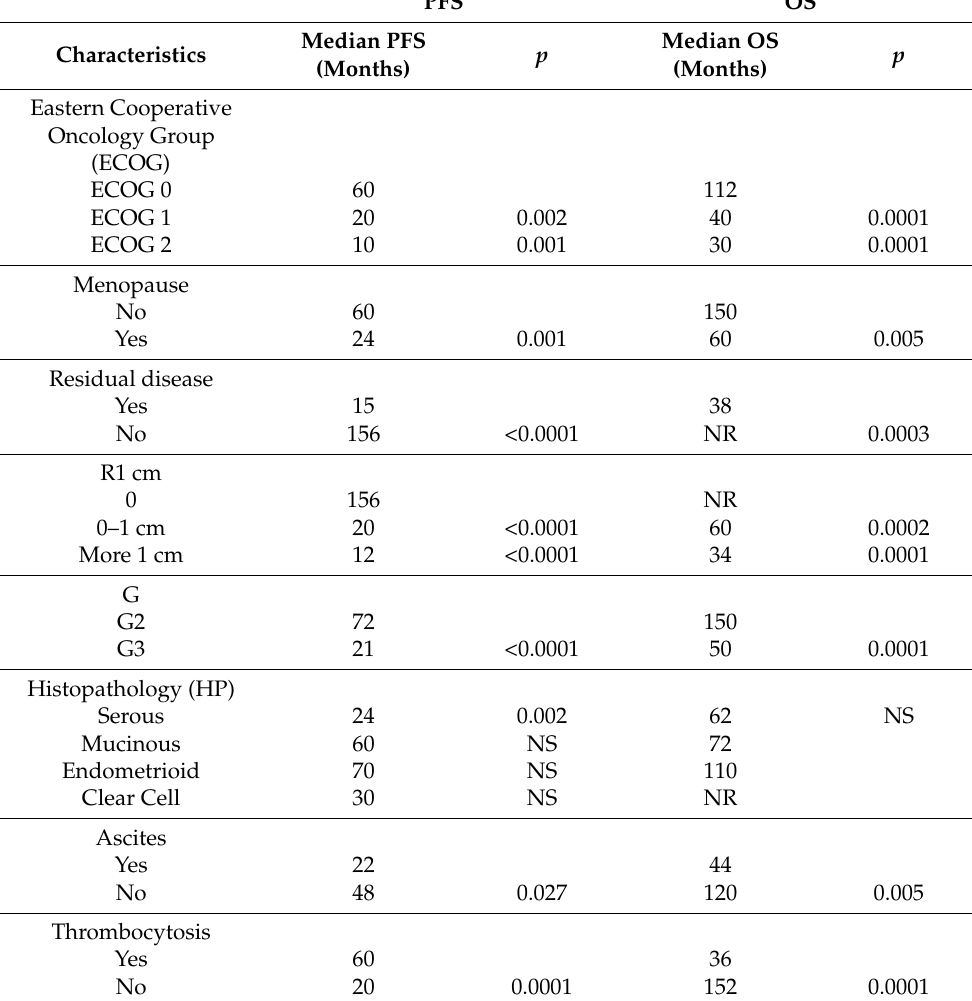
Table 1. Progression-free survival (PFS) and overall survival (OS) according to prognostic factors. PFS OS Median Characteristics